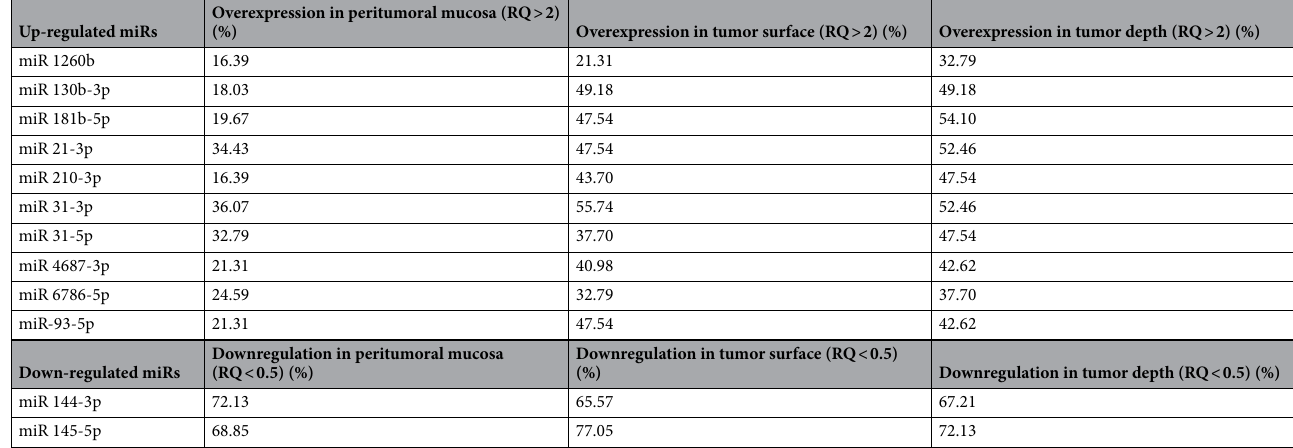
Table 1. Dysregulation rate among cases for all 12 validated microRNAs.